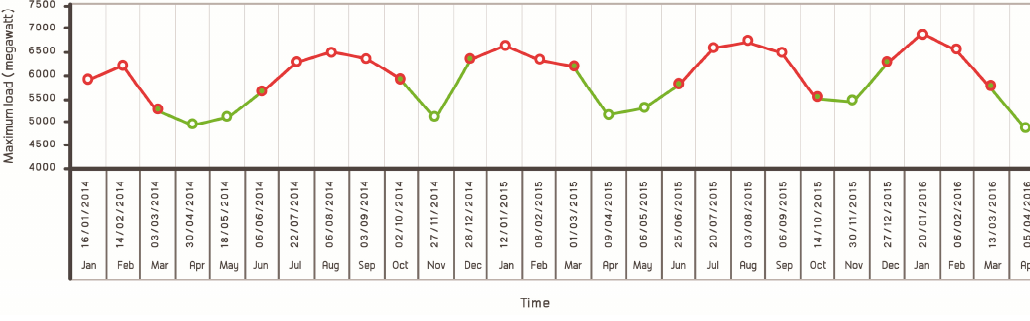
Figure 1. Electricity demand between 2014 and 2016.